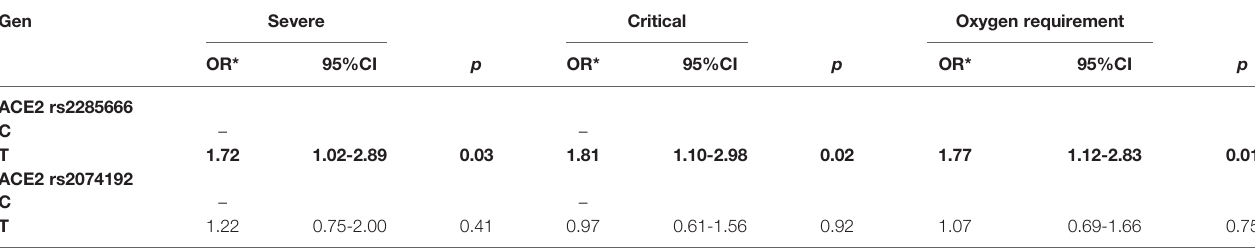
TABLE 4 | Association of ACE2 alleles with COVID-19 outcome in men. Gen